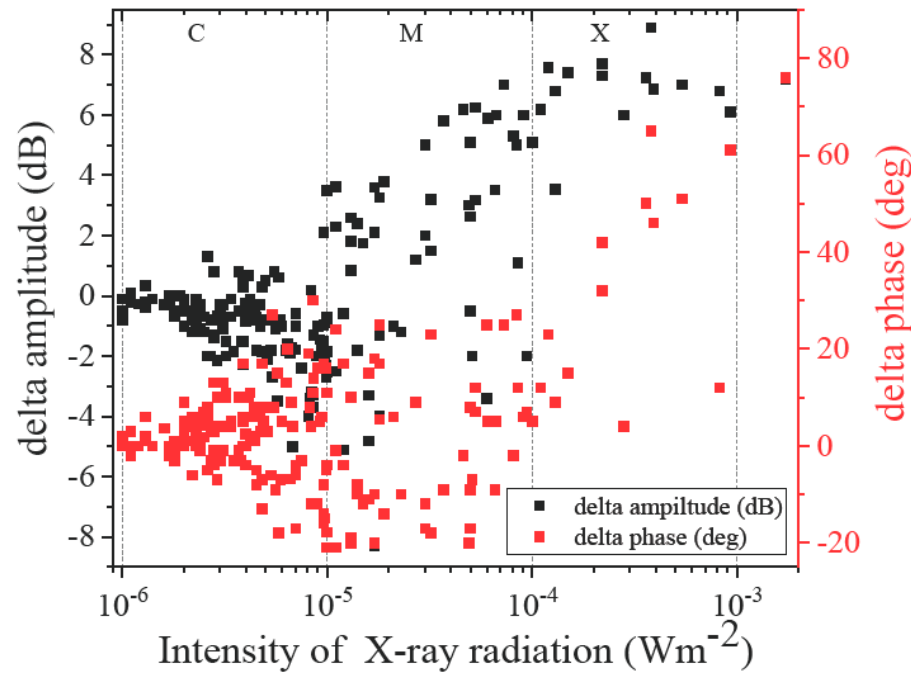
Figure 3. ( left ) Observed amplitude perturbations on GQD/22.10 kHz radio signals due to solar X ‐ ray flares, measured at Belgrade station during period (2003–2017) as a function of X ‐ ray flux. ( right ) Observed phase perturbations under same conditions. Two hundred events of solar X ‐ ray flares were